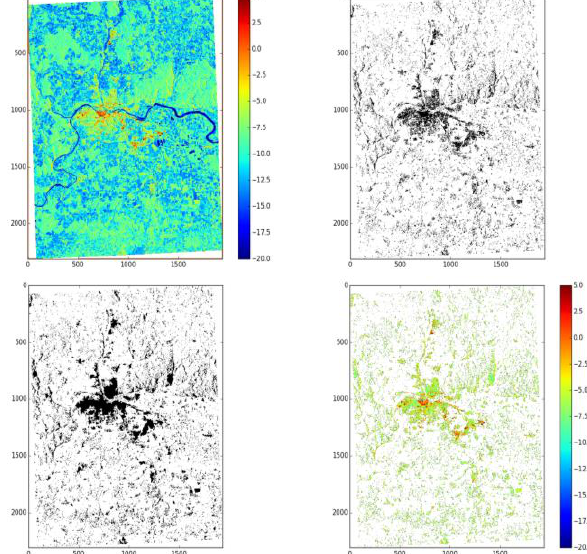
Figure 5. SAR rule based classification results for the land cover class ‘Urban’ in Test site no.1 (Fig. 3 subset with violet border) Top left: SAR image of test site no. 1 where backscatter intensity varies in dB. Top right: pixels classified in the land cover class ‘urban’, bottom left: objects formed from the classified pixels, bottom right: final classification results for the land cover class ‘Urban’.